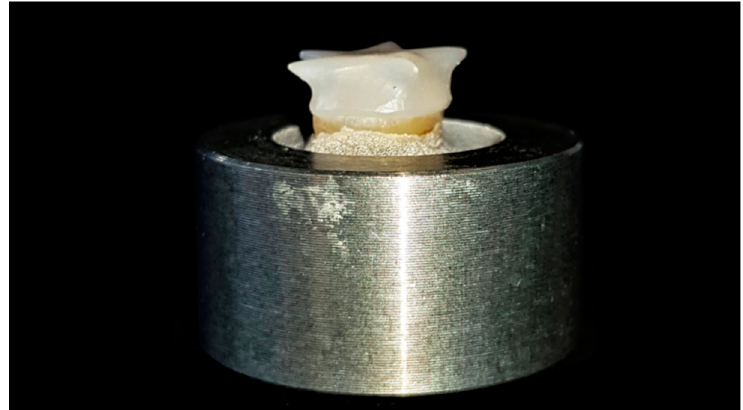
Figure 7. Adhesively luted zirconia crown.